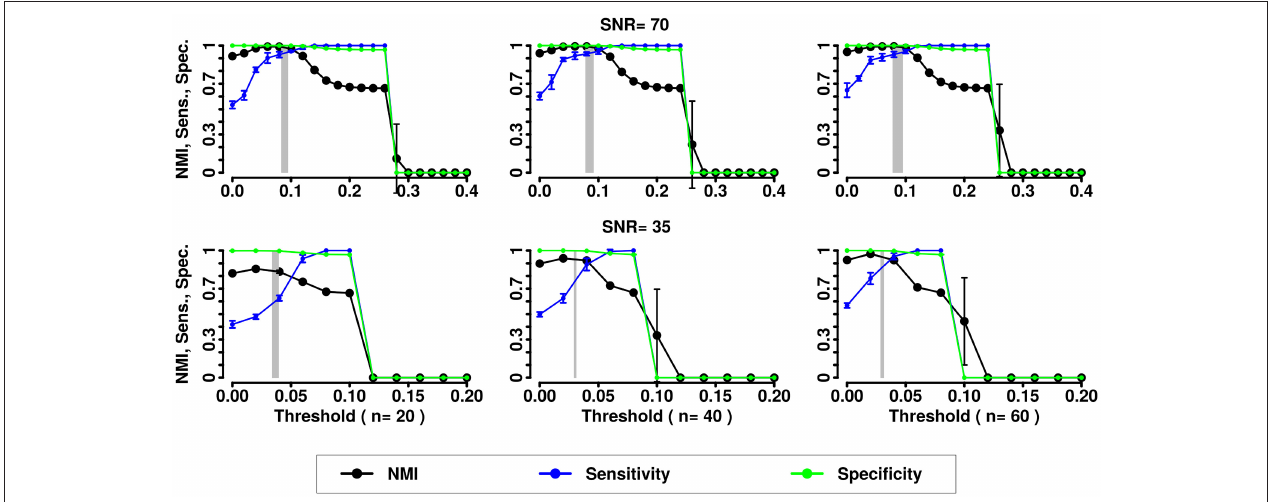
FIGURE 5 | NMI (in black), Sensitivity (in blue), and Specificity (in green) of the Newman community detection algorithm applied to LFR networks ( µ t = µ w = 0.2). Two different signal to noise ratio (SNR) are represented on the lines (top line SNR = 70, lower line SNR = 35), Number of subjects varies depending of the column (respectively from left to right 20, 40, and 60 subjects).